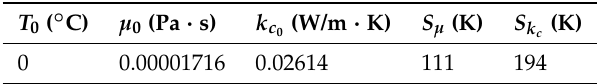
Table 1. Sutherland’s law coefficients